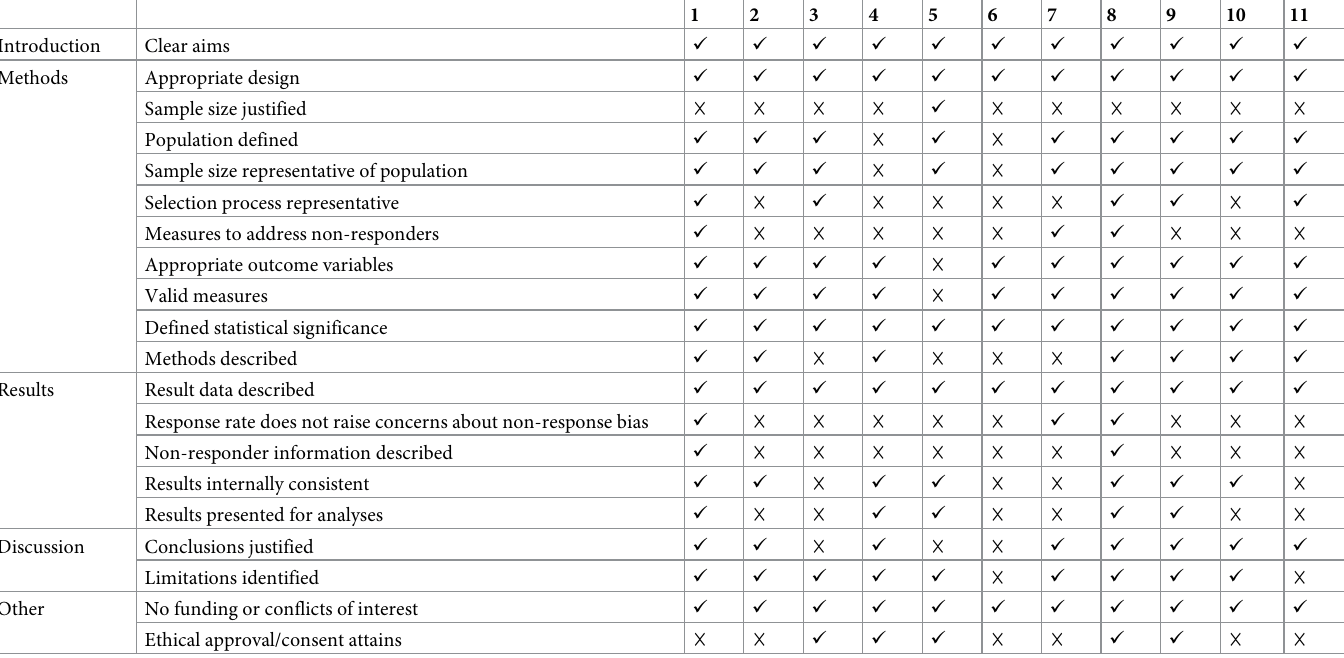
Table 1. AXIS quality assessment appraisal for studies included in the systematic